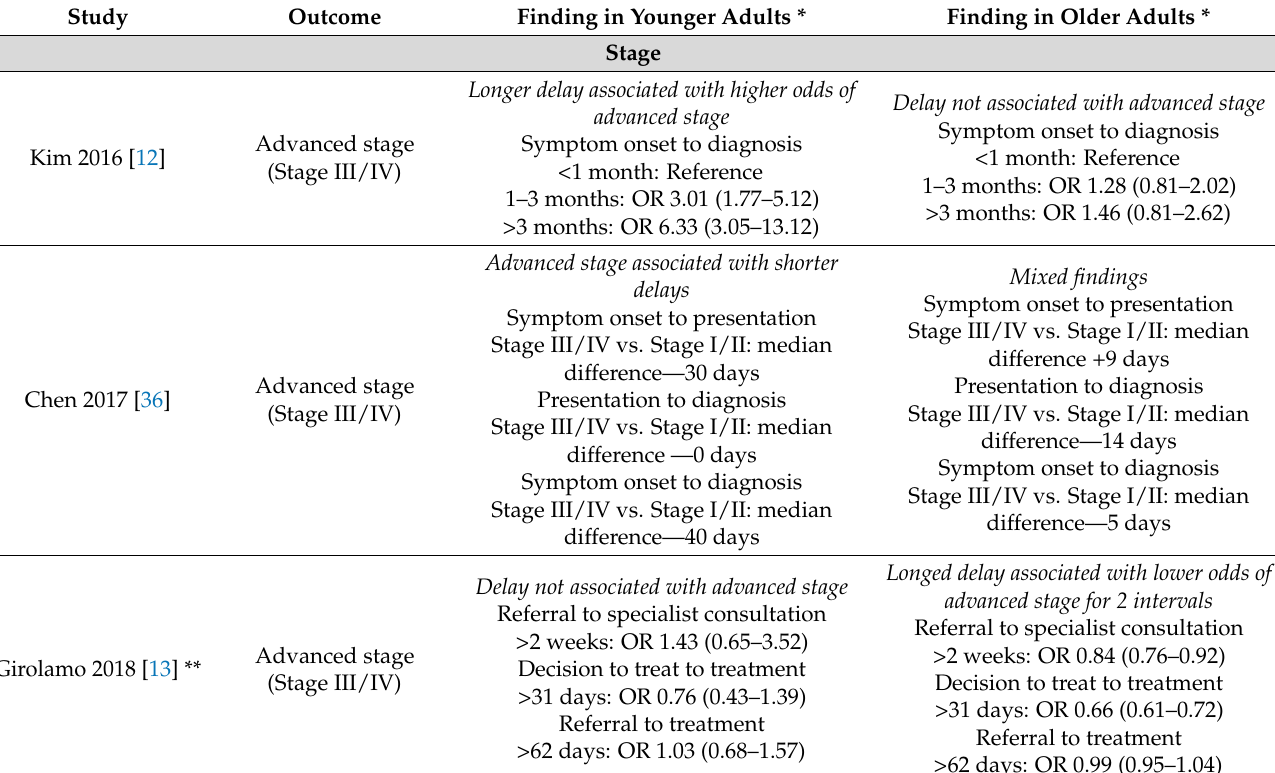
Table 3. Associations between delay intervals and stage at presentation and survival between younger and older adults with colorectal